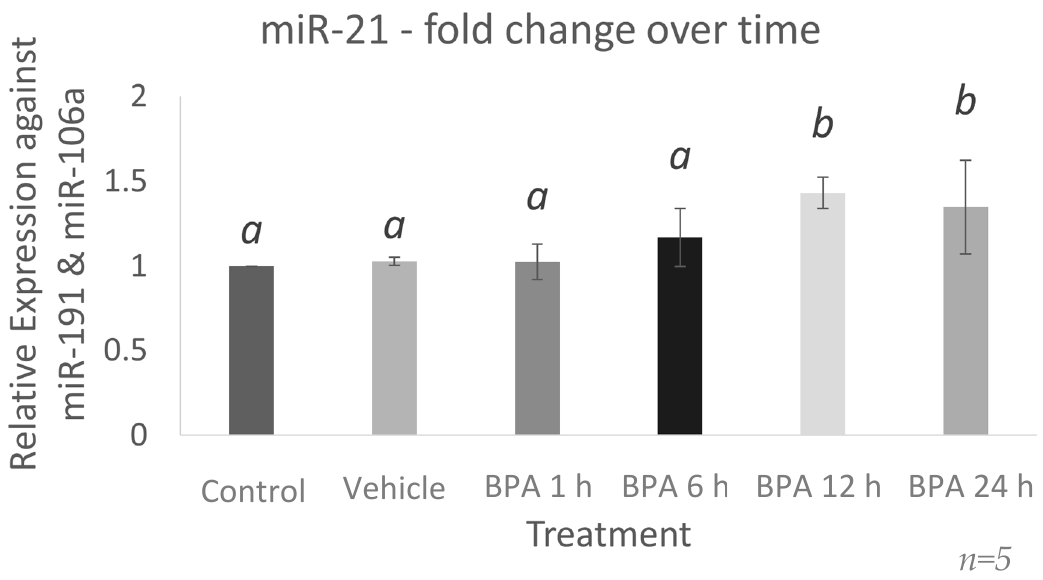
Figure 1. mi-21-fold change over time after BPA treatment . miR-21 significantly increased after 12 and 24 h of BPA treatment. All samples originated from in vitro cultured granulosa cells treated with 0.05 mg/mL BPA for 1, 6, 12, and 24 h. Quantification is relative to reference targets miR-191 and miR-106a. Different letters indicate significant differences, with b indicating a significantly different mean than a at p < 0.05. Bars represent the mean ± SEM.